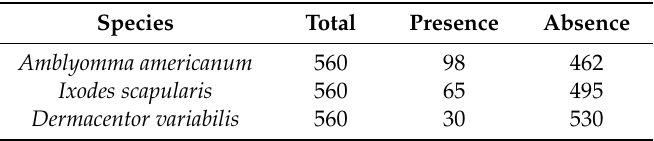
Table 1. Number of presence / absence observations used for modeling each species. The total number ( n = 560) and geographic location of observations is conserved for each species, with only observed occurrence (presence)